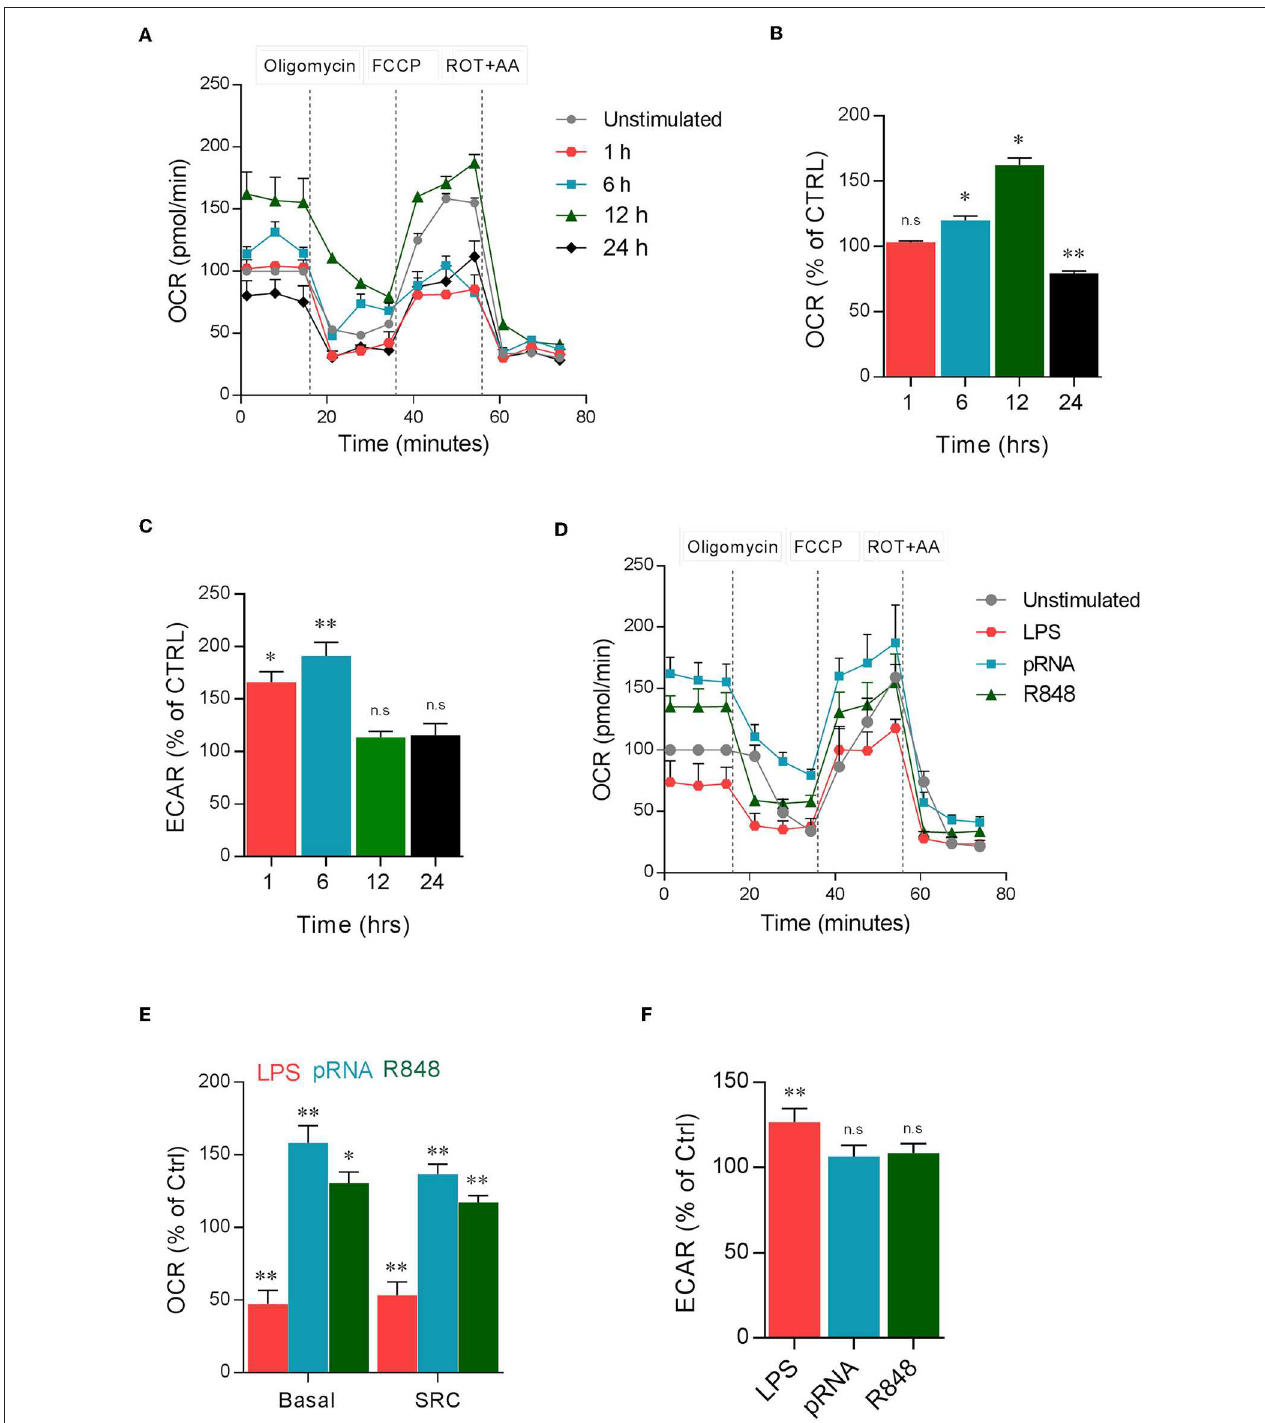
FIGURE 1 | TLR ligands induced metabolic changes in DC. (A) Mitochondrial fitness test of DCs stimulated with pRNA for indicated time points. Data represents mean ± SEM of three independent experiments. (B,C) Data was collected within same experiments as (A) , but is shown separately for better understanding. Data represents mean ± SEM of three independent experiments performed in triplicate. * p < 0.05; ** p < 0.01 (two-way ANOVA). (D) Mitochondrial fitness test of DCs stimulated with LPS (100ng/mL), pRNA and R848 (1 µ g/ml) for 12h. Data represents mean ± SEM of three independent experiments performed in triplicate. (E,F) Data was collected within same experiments as (D) , but is shown separately for better understanding. Data represents mean ± SEM of three independent experiments performed in triplicate. * p < 0.05; ** p < 0.01 (two-way ANOVA).